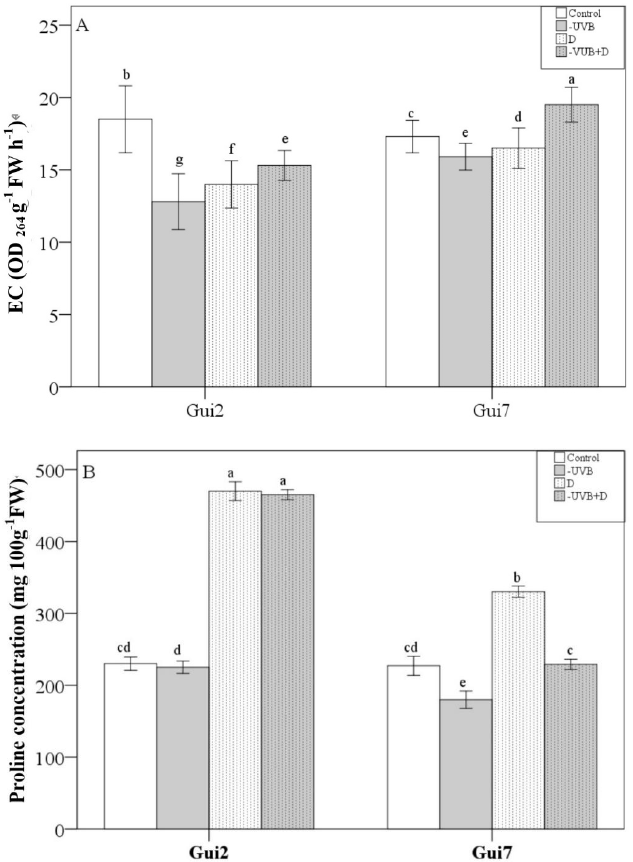
Leaf membrane value and leaf proline content were significantly affected by cultivar, UV ‐ B, drought, and their interactions (Table 1). UV ‐ B exclusion significantly decreased tissue electric conductivity (EC), a membrane permeability trait, under well ‐ watered conditions, in particular in Gui 2, but increased significantly under drought in both cultivars (Figure 2A) which was what demonstrated that solar UV ‐ B radiation moderated drought effects. Mild drought reduced EC under an ambient UV ‐ B condition and increased EC under a UV ‐ B exclusion condition.